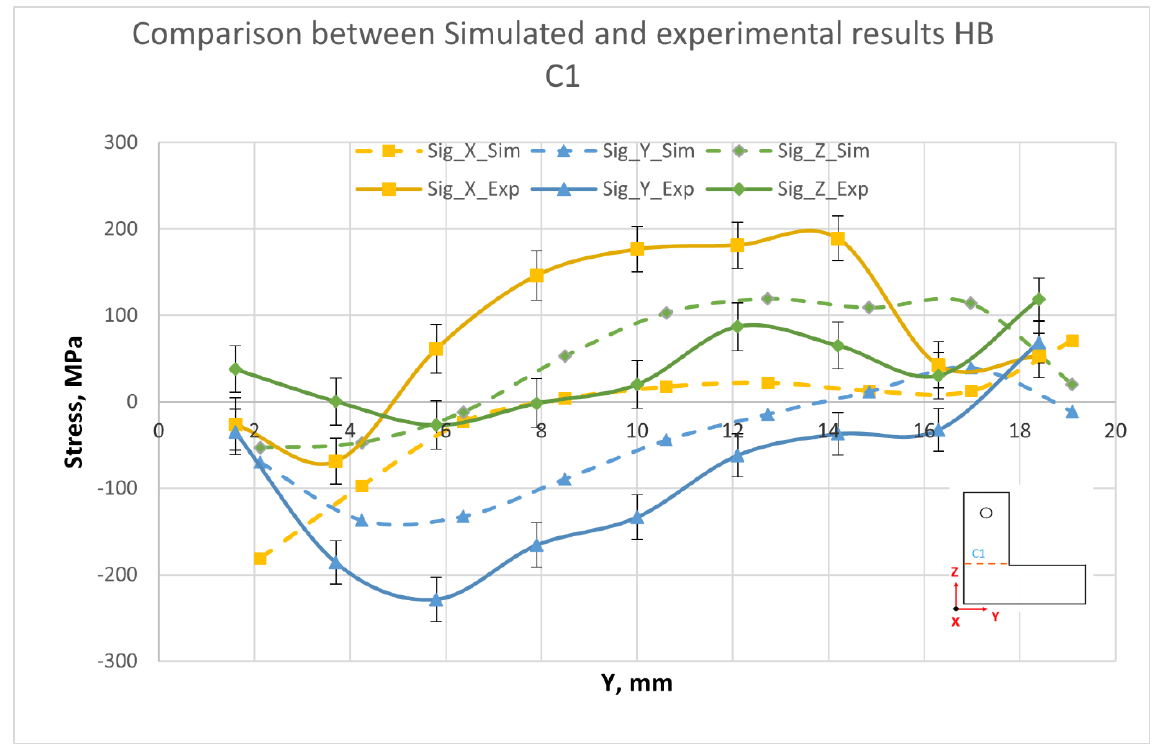
Figure 18. Comparison between experiment and simulation results for HB sample cross-section C1.